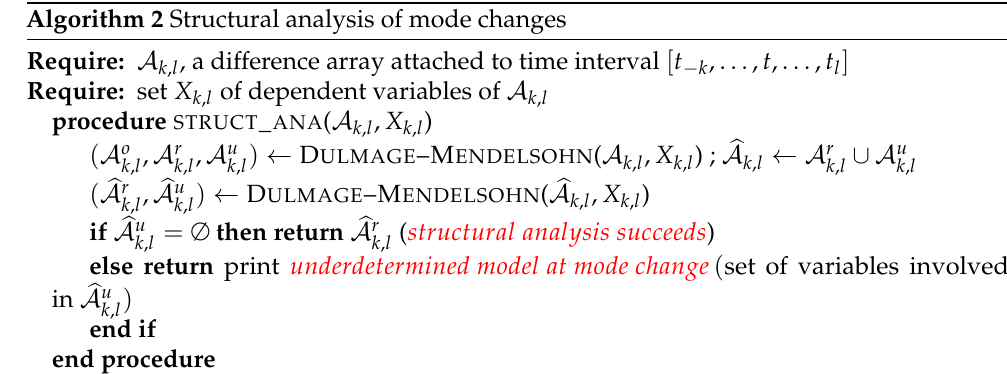
Algorithm 2 Structural analysis of mode